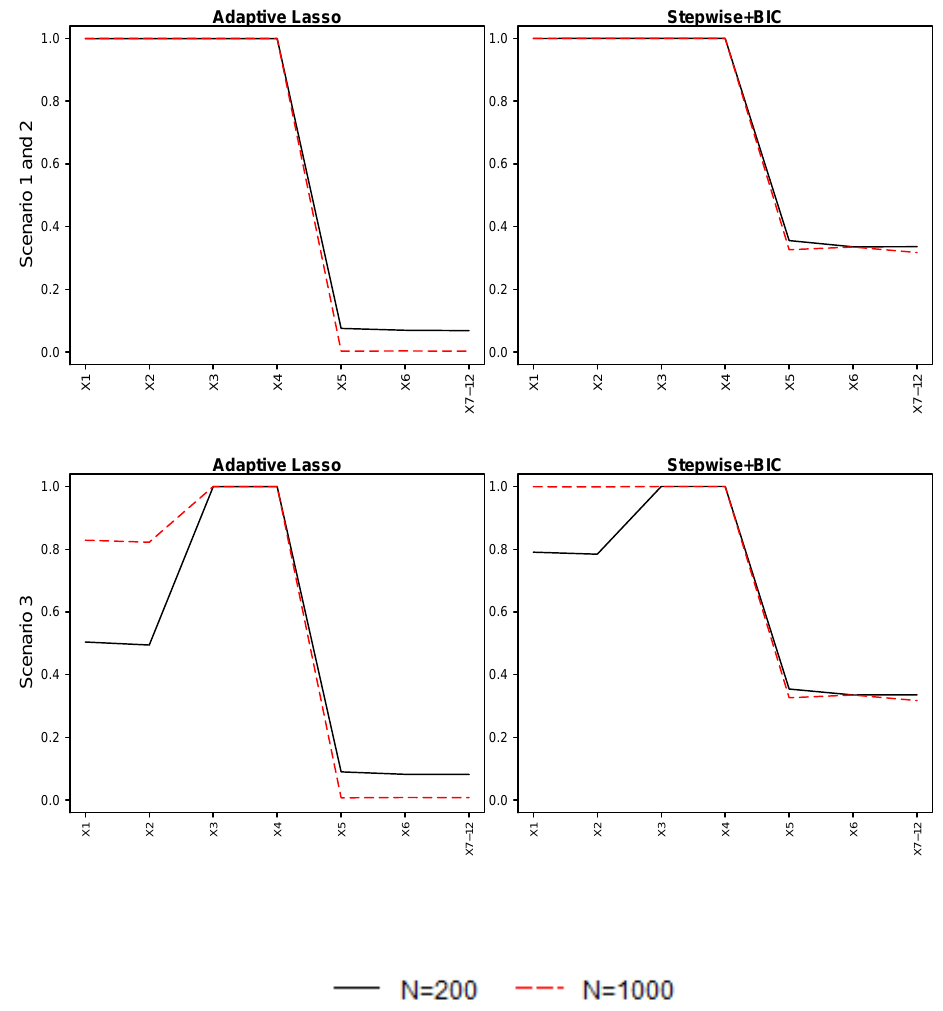
Figure A2. Proportions of each variable selected for prediction model across 500 simulated datasets and 1000 bootstrap samples for each simulated dataset for sample size of 200 and 1000. X 1 and X 2 are the true confounders; X 3 and X 4 are predictors of the outcome but not of the treatment; and X 5 and X 6 are predictors of the treatment but not of the outcome; all the other 14 covariates are spurious. Average across the spurious